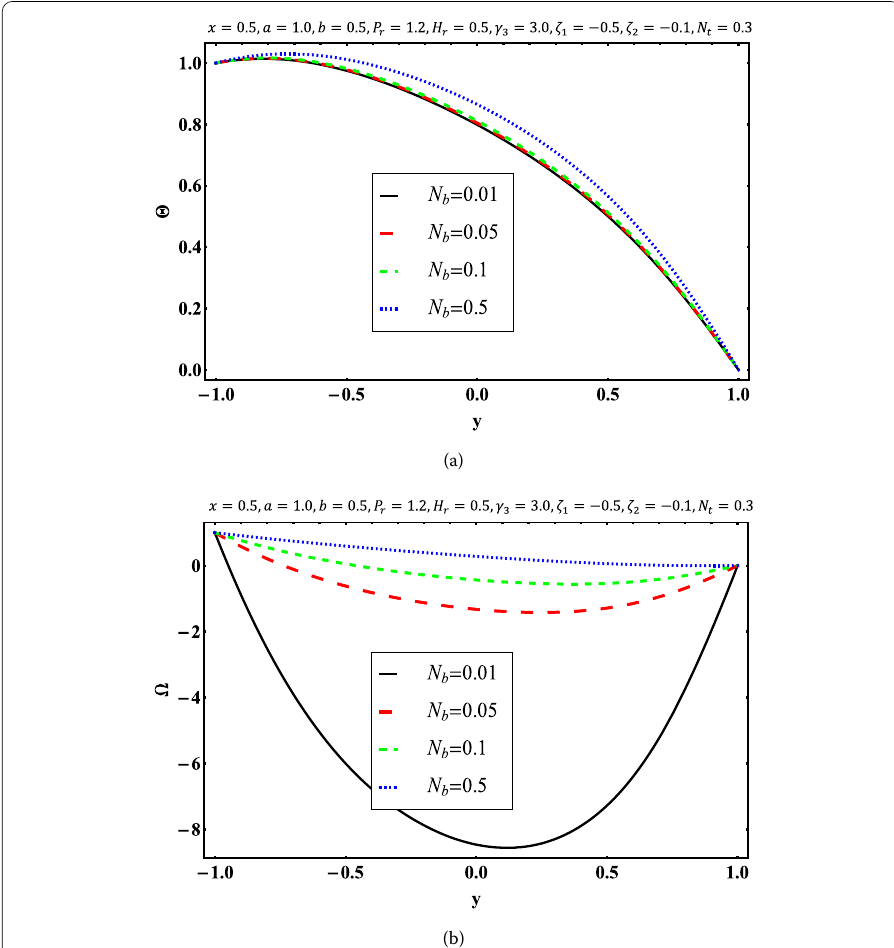
Figure 13 For different values of N b , ( a ) temperature distribution Θ and ( b ) concentration distribution Ω .